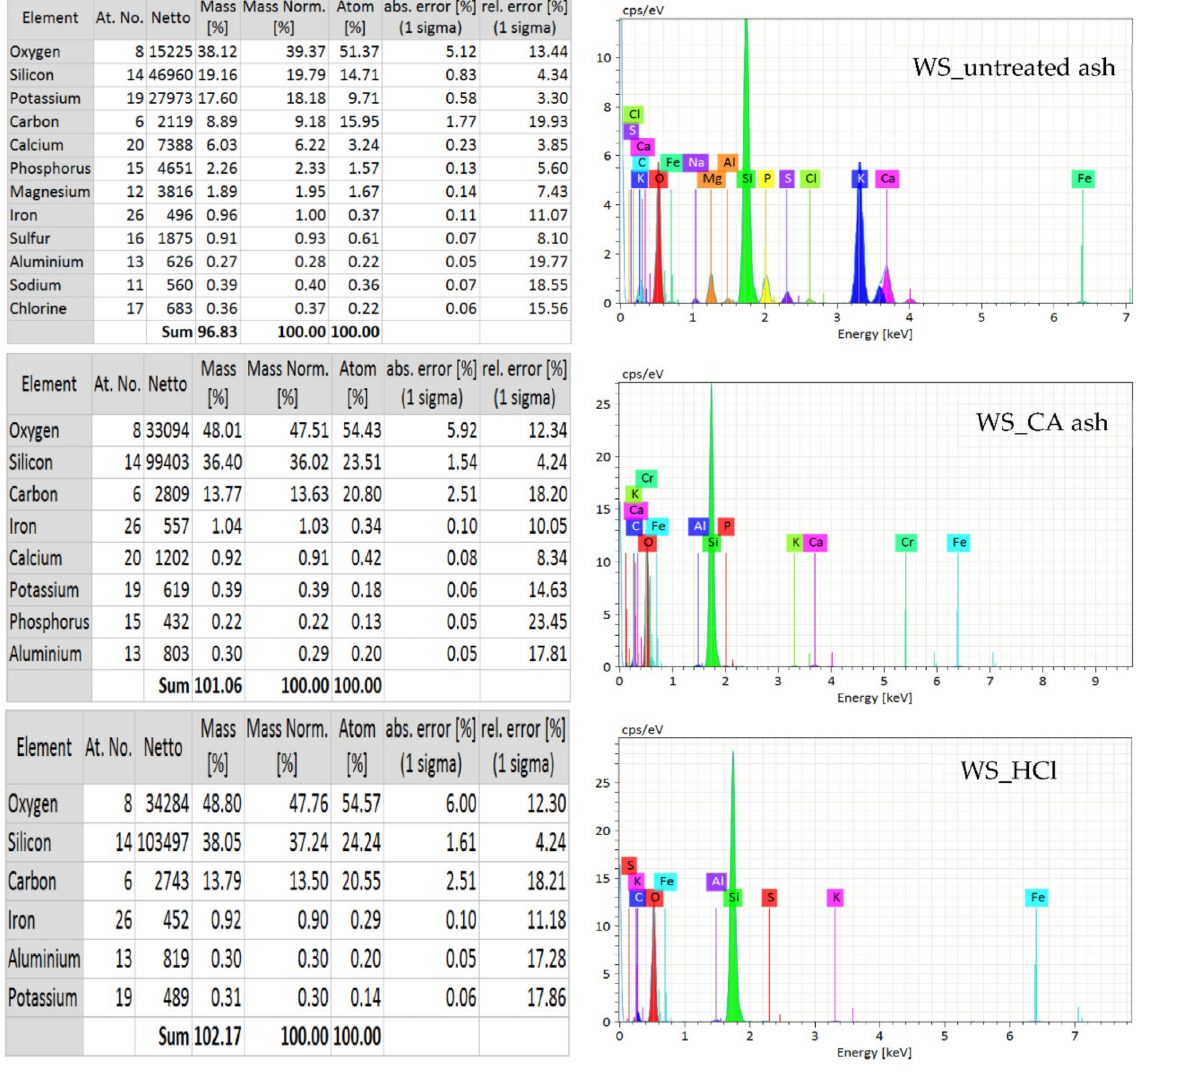
Figure 6. Elemental composition of wheat straw